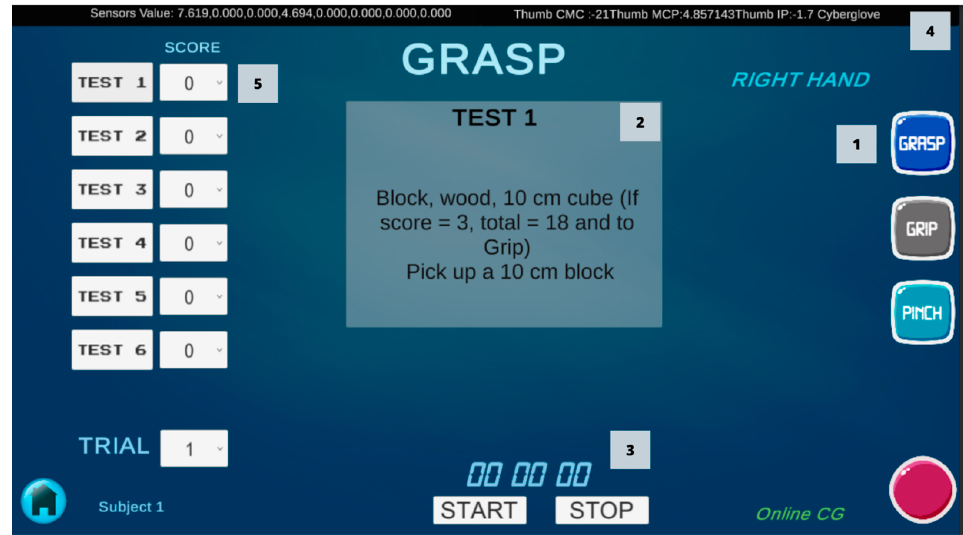
Figure 2. ARAT scene of the Graphical User Interface; (1) Buttons to select each subscale; (2) Description of the test; (3) Buttons to record each test with timer; (4) Sensors information in real-time (angle finger joints and forces); (5) Dropdown list to score each test.